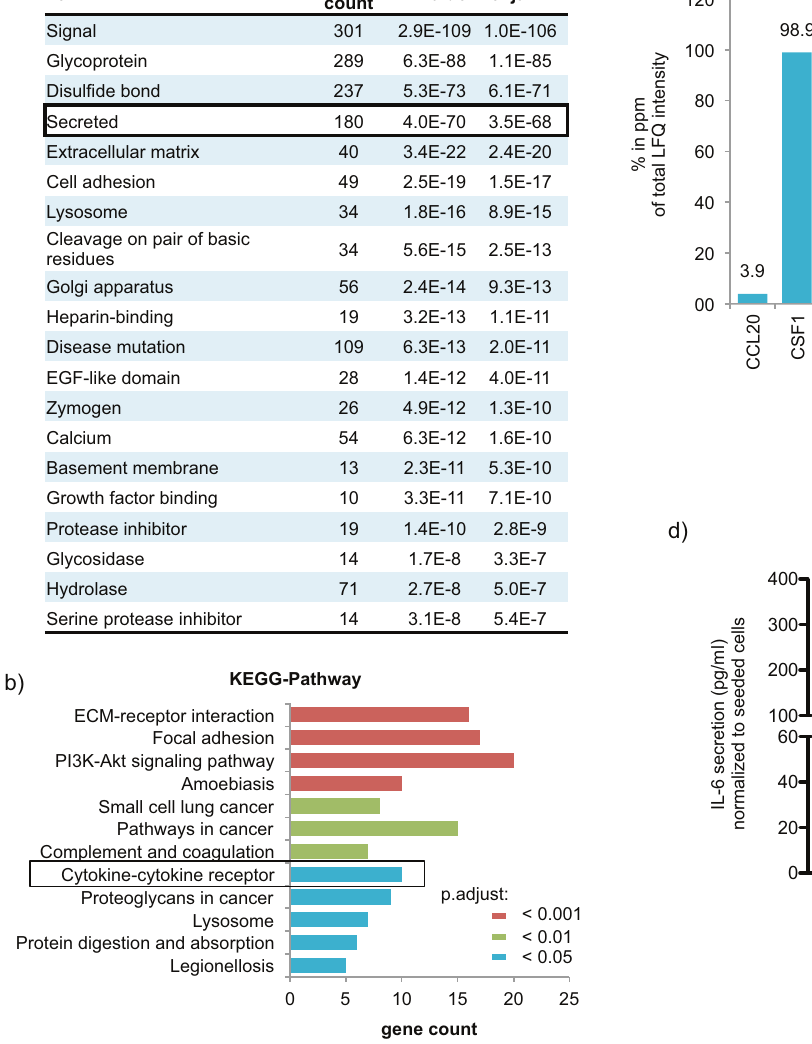
Fig. 2 Identi fi cation of IL-6 among the secreted factors. a Mass-spectrometry based analysis was performed to identify secreted factors in the supernatant of NCI-H226 cells. The threshold of the LFQ intensities of identi fi ed proteins was set as log 2 ratio < − 1. The identi fi ed secreted factors were classi fi ed using DAVID Bioinformatics Resources 6.8 with the settings “ Functional_Categories: UP_Keywords ” . Shown are the top 20 groups revealing among others the category “ secreted ” . b The 180 proteins of the in a , identi fi ed category “ secreted ” were further analyzed using DAVID Bioinformatics Resources 6.8 with the settings “ KEGG pathways ” . Only the pathways with Benjamin p -value< 0.05 are illustrated. c Displayed are the fa c tors of the in b, identi fi ed pathway “ cytokine-cytokine receptor ” . Shown are the respective percentages in ppm of the total LFQ intensities. d IL-6 secretion of NCI - H226, NCI-H2122, and NCI-H1650 was determined after 5 h incubation, while IL-6 secretion of Saleb cells was studied after 6 h and 24 h incubation (mean ± SD; n = 2). recapitulated our results on the secretion of IL-12p70, TNF- α , IL-8, Next, we addressed the question of whether IL-6 is the factor in and IL-10 seen after the addition of NCI-H226 or NCI-H2122 the NCI-H226 supernatant that affects the LPS-induced secretion supernatants (Supplementary Fig. 3a-d). Despite high deviation, IL- of IL-12p70 from moDCs. Indeed, the addition of tocilizumab (anti- 12A and IL-12B mRNA levels are slightly reduced after treating IL-6R mAb) abrogated the inhibitory effect of NCI-H226 culture LPS-stimulated moDCs with NCI-H226 culture supernatant or with supernatant on IL-12p70 secretion from moDCs, suggesting a IL-6 (Supplementary Fig. 3e, f) pointing to regulation on the strong IL-6 dependency (Fig. 3a). This IL-6 dependency could be transcriptional level. Additionally, we investigated how the super- further con fi rmed in an IL-6 depletion experiment since moDCs natant of lung cancer cells that do not secrete IL-6 affects the LPS- cultured in the presence of IL-6-depleted NCI-H226 supernatant induced maturation of moDCs. Therefore, we cultured moDCs in showed signi fi cantly stronger induction of IL-12p70 secretion the presence of the supernatant of A549 cells. As with the compared to moDCs cultured in the NCI-H226 supernatant supernatants of IL-6 producers, we did not observe any effects on without prior IL-6 depletion (Fig. 3b). In line with this, the the LPS-induced surface expression of moDCs cultured with presence of IL-6 during moDC differentiation and maturation Cell Death and Disease (2021)